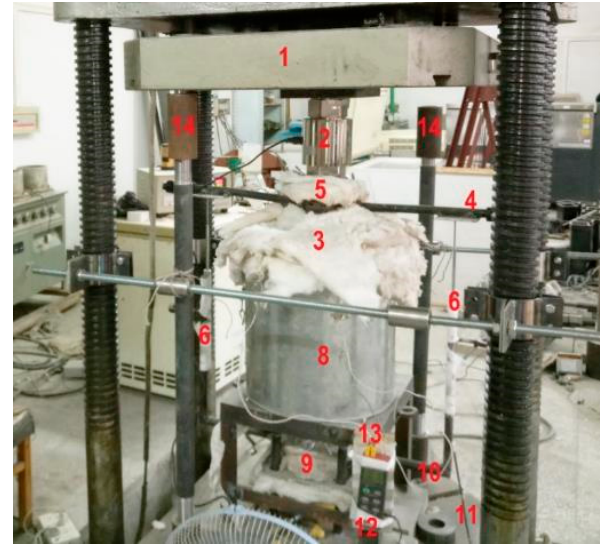
( a ) Test-setup for simultaneous heating and loading Figure 1.